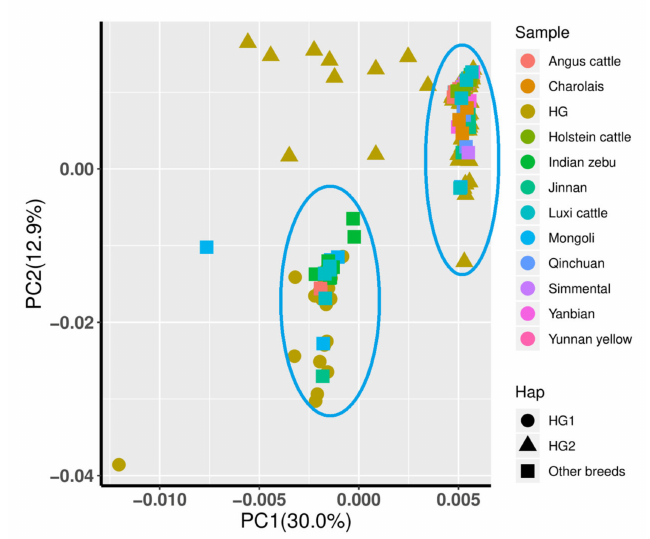
Figure 4. Principle components analysis (the top two components were shown) of two haplotypes and homologous sequences of other breeds from the NCBI database. Haps mean different haplogroups of Chinese Holstein cows or other breeds and are shown in different shapes. Sample representing different breeds or haplogroups are shown in different